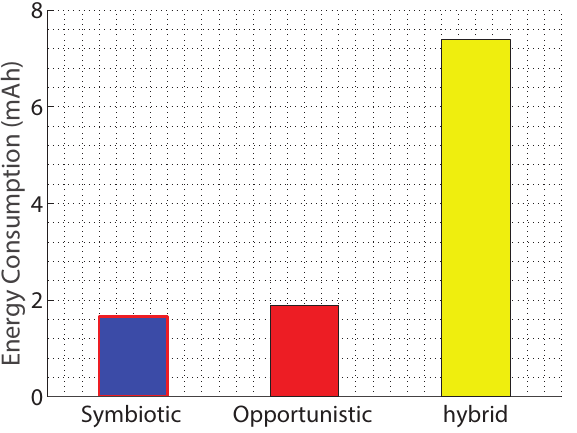
Figure 6. Evaluation of the NeriCell [13] honk detection application in terms of the estimated energy consumption when applying opportunistic sensing (original work), symbiotic sensing, and hybrid